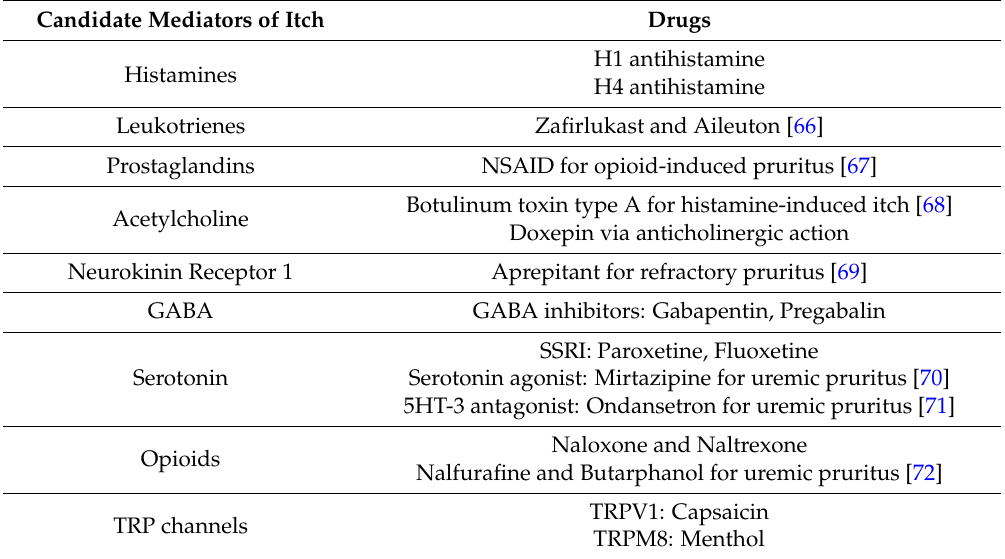
NSAID, Non-Steroid Anti-Inflammatory Drug; GABA, γ -Aminobutyric acid; SSRI, Selective serotonin reuptake inhibitor; TRP, Transient receptor potential; TRPV, vanilloid receptor–related transient receptor